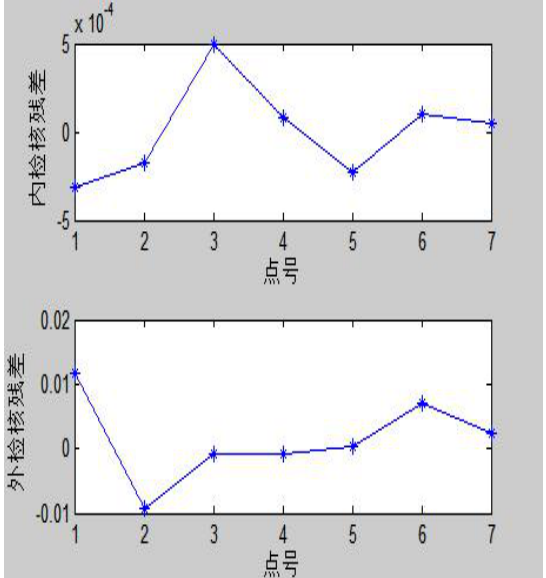
Figure 4 Fitted internal and external check residual distribution